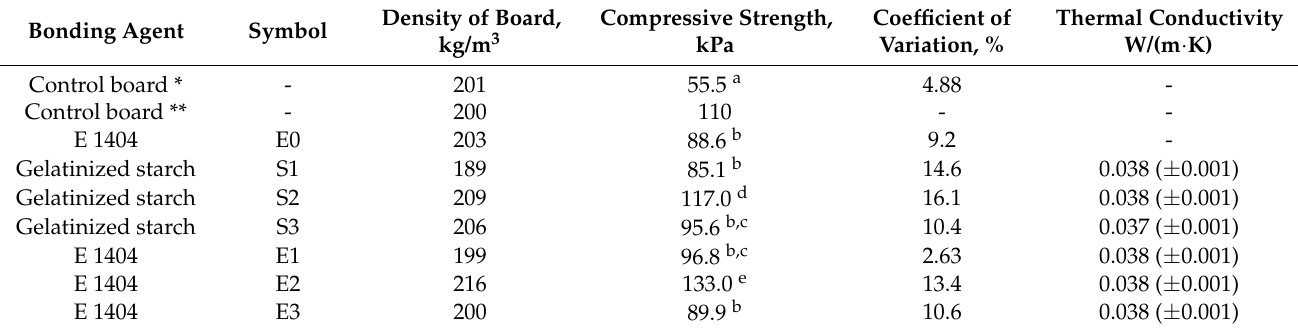
Table 3. Effect of manufacturing parameters on the compressive strength of manufactured boards—fiber moisture